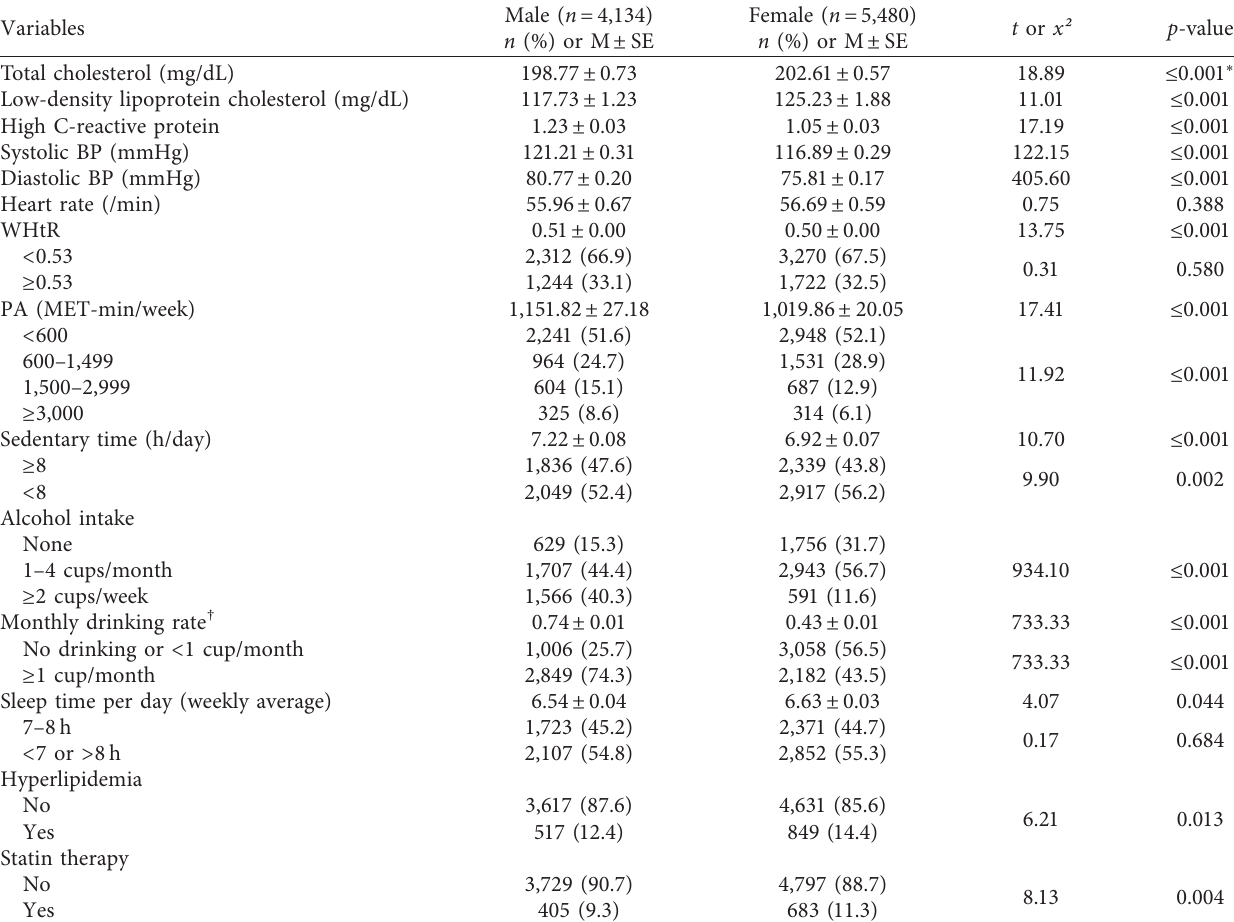
Table 3: Comparison of major risk factors for T2DM in Korean adults according to sex ( n � 9,614).